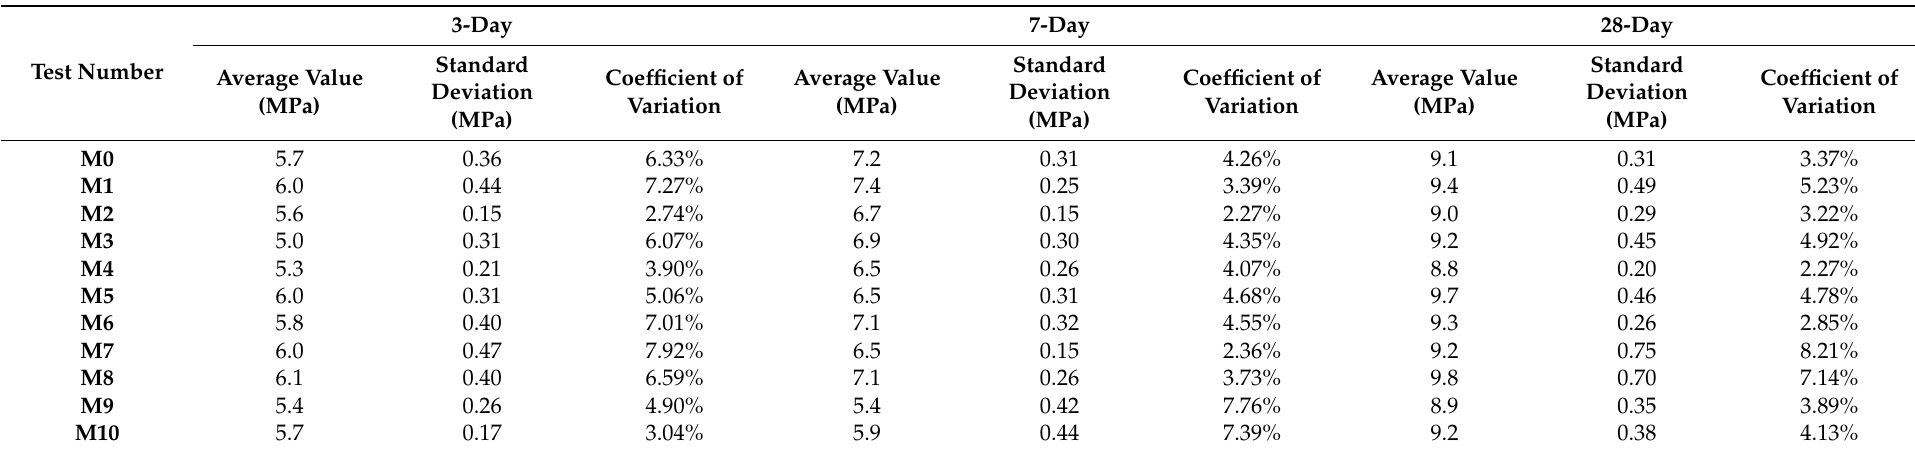
Table 6. Test results of mortar flexural strength of machine-made